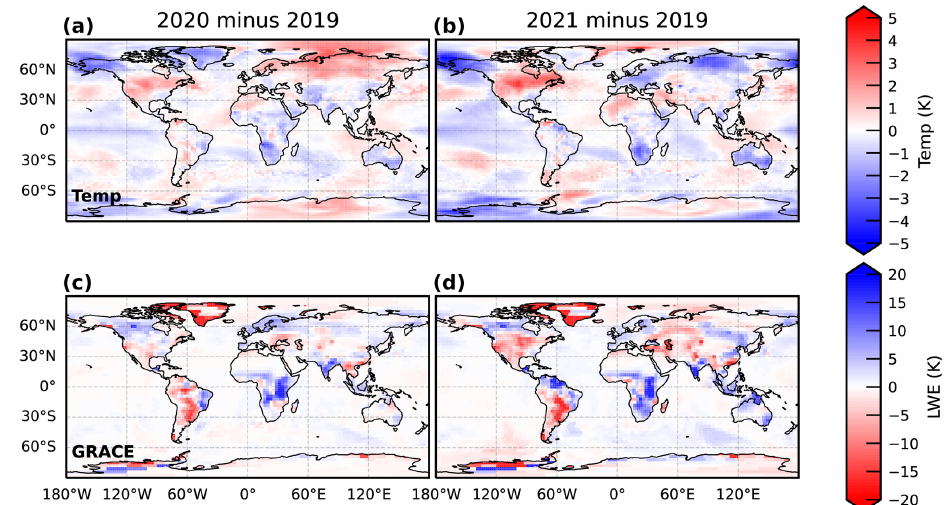
Figure 3. Global annual mean surface temperature and GRACE liquid water equivalent (LWE) anomalies in (a, c) 2020 and (b, d) 2021 relative to values in